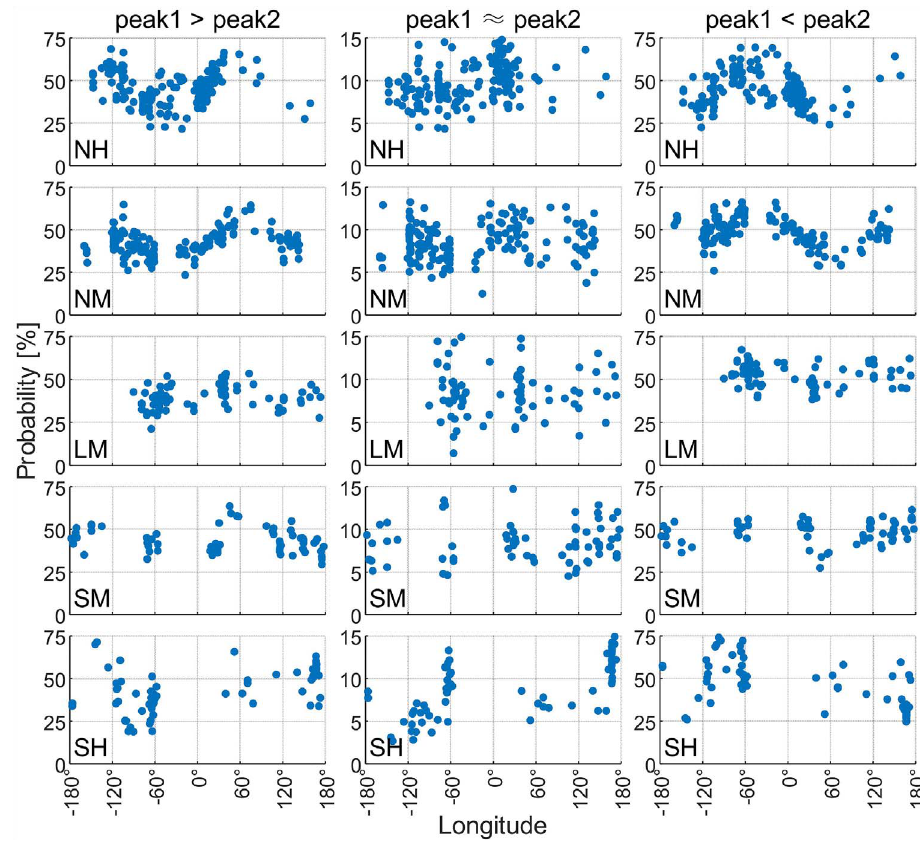
Figure 8. The variation of the comparison of the magnitude of the two peaks in different MLAT regions with the